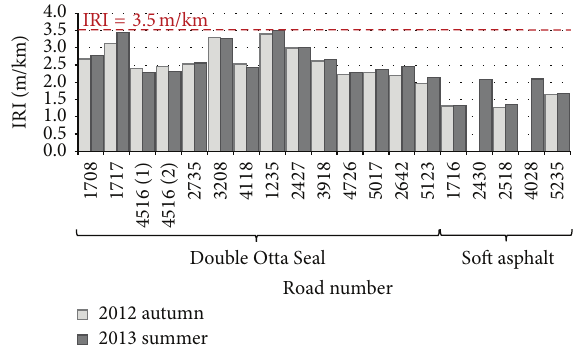
Figure 5: IRI (horizontal hyphenated line shows the maximum